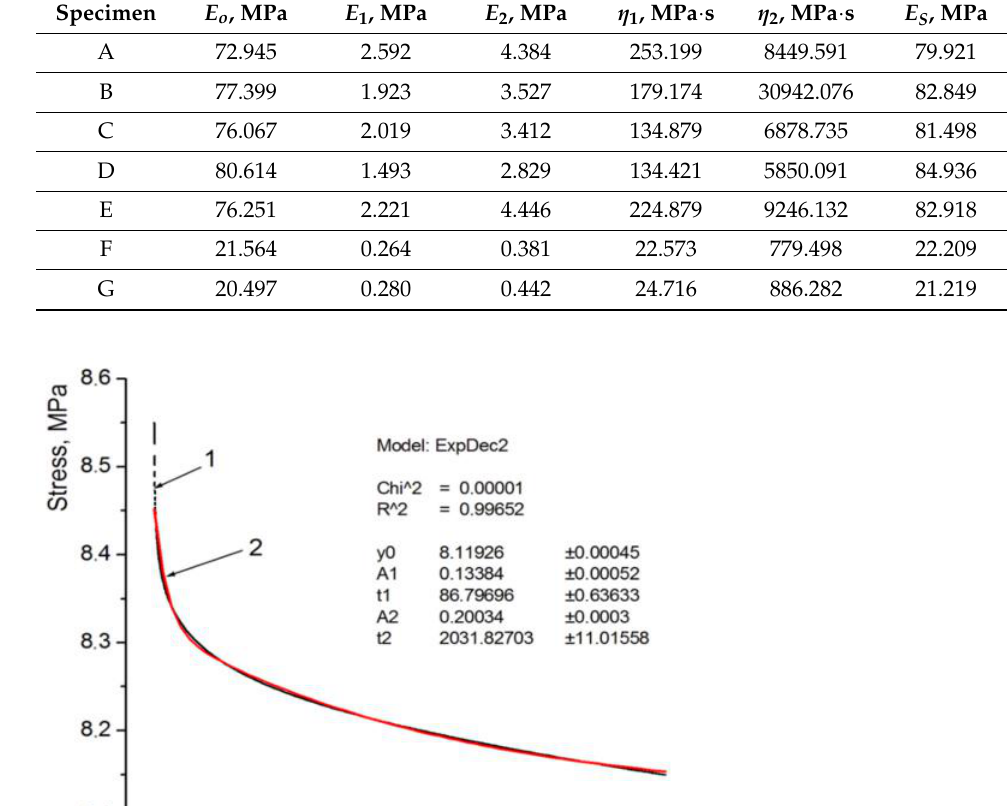
Table 5. Parameters of the rheological model.